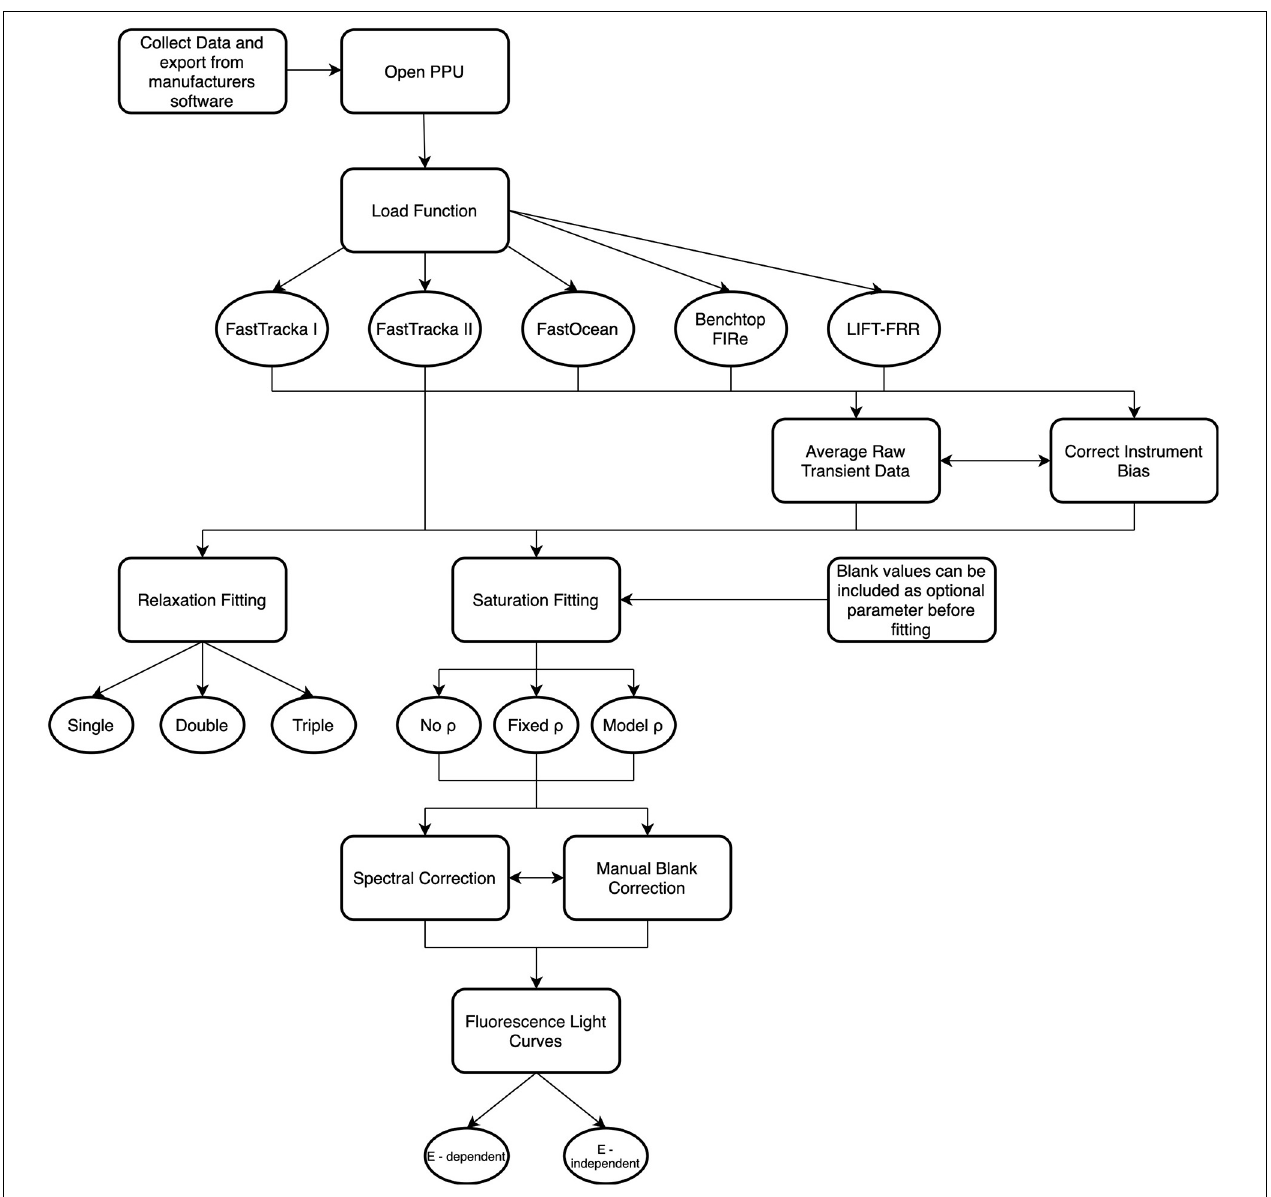
FIGURE 2 | Schematic overview of the functions available within Phytoplankton Photophysiology Utilities. For further details on specific function descriptions see Supplementary Table 2